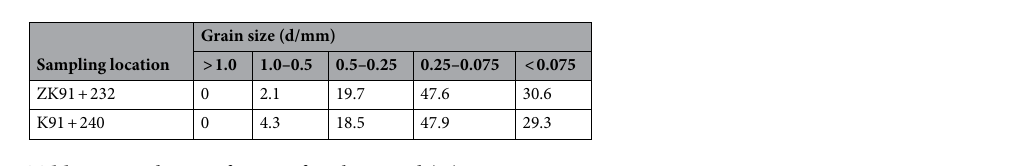
Table 2. Gradation of grain of aeolian sand